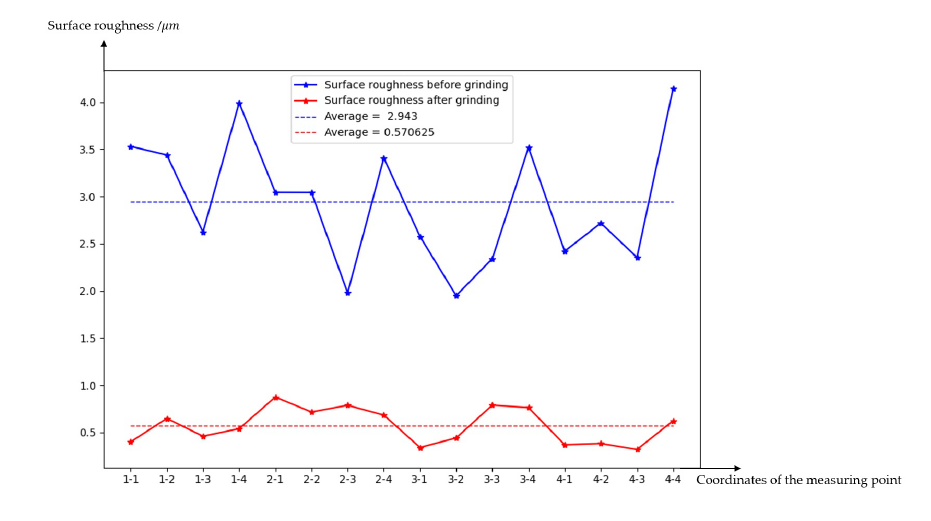
Figure 28. Roughness comparison of each point before and after